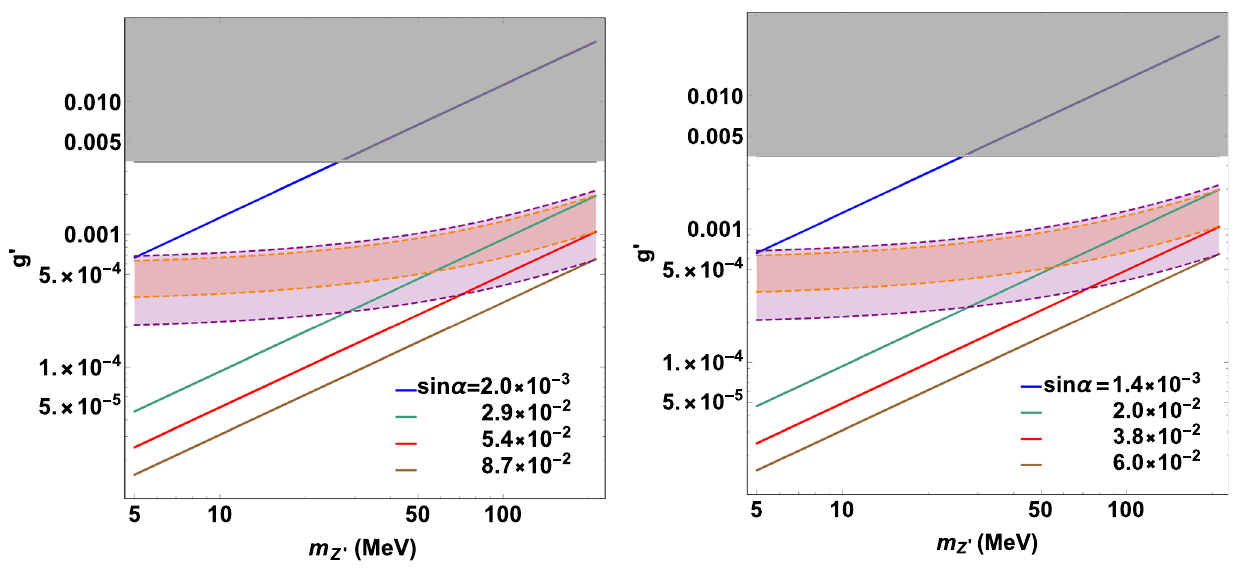
to each line are shown in the figures. The favored regions of ( g − 2 ) μ within 2 σ and 3 σ are indicated by the orange and purple bands. The gray area is excluded by the neutrino trident production